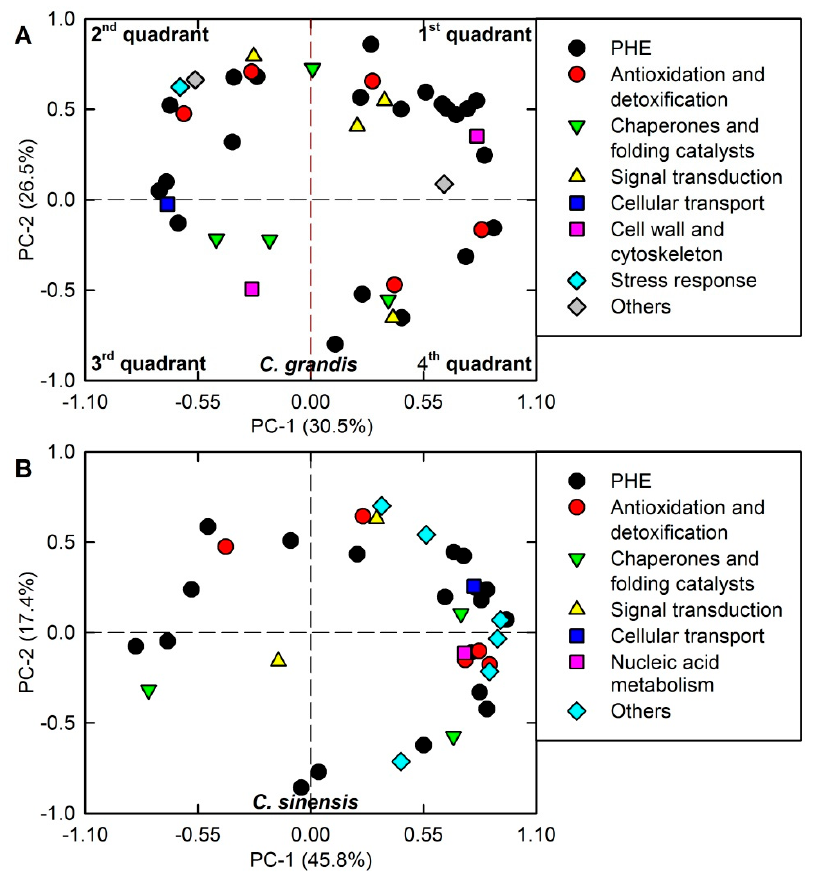
Figure 4. Principal component analysis (PCA) of differentially abundant proteins (DAPs) in Cu-treated Citrus grandis ( A ) and Citrus sinensis ( B ) leaves. PHE: photosynthesis, carbohydrate and energy metabolism.